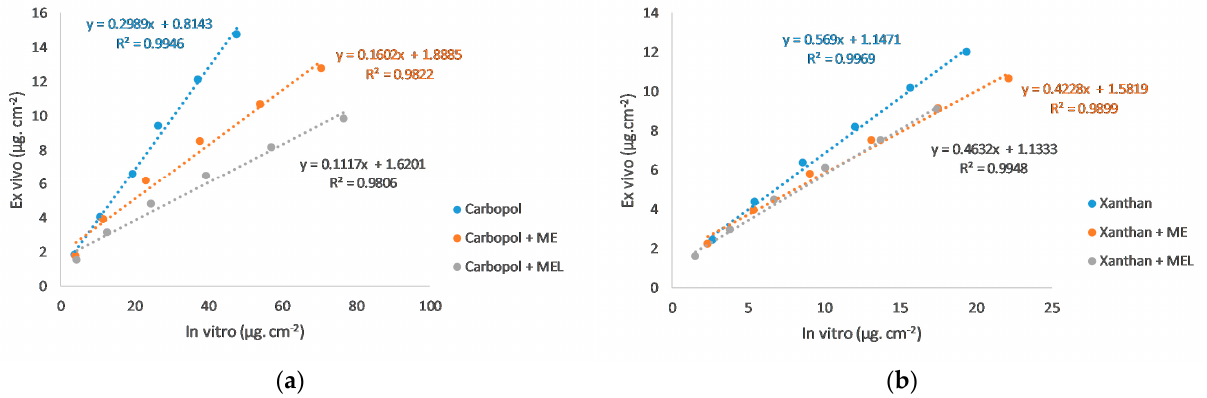
Figure 8. The correlation between the in vitro (synthetic membrane) and the ex vivo (animal skin) drug release: ( a ) Carbopol gel; ( b ) Xanthan gel.